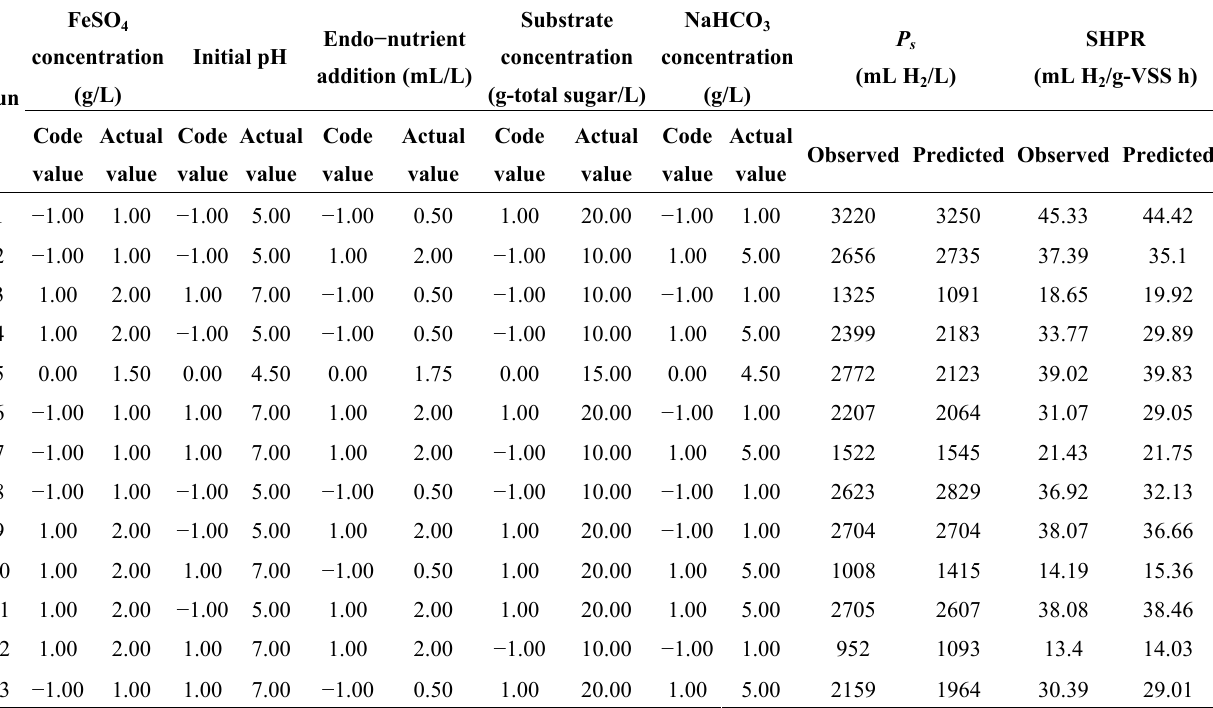
Table 7. Plackett–Burman design matrix for evaluating factors influencing P from pineapple waste extract by anaerobic mixed